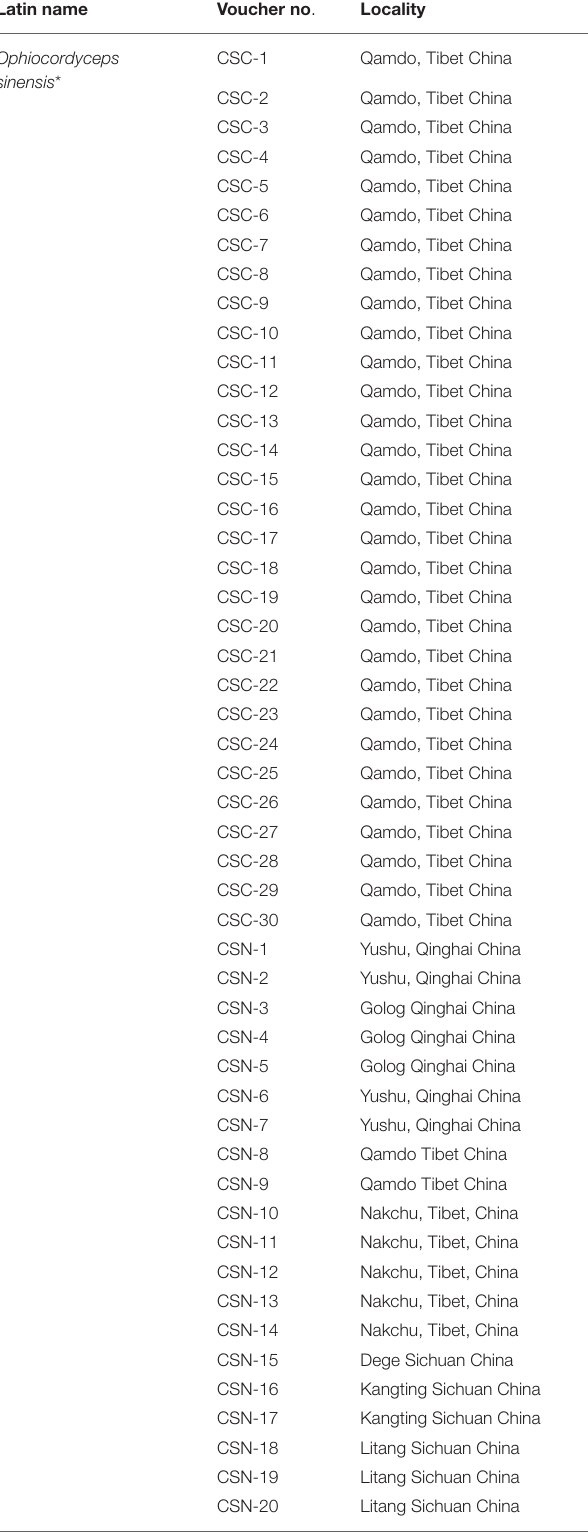
TABLE 1 | Information for the samples of O . sinensis and its counterfeits used in this study. Latin name Voucher no